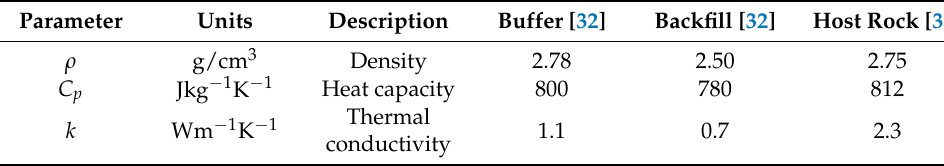
Table 2. Parameters for heat transport